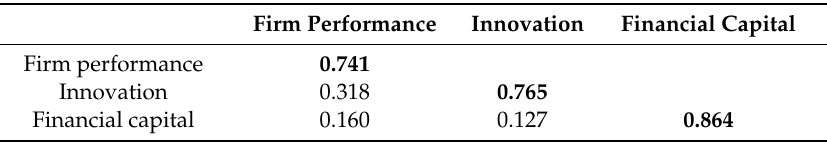
Table 6. Fornell–Larcker test of discriminant